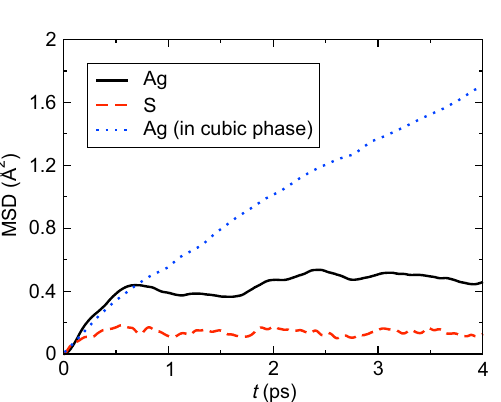
Figure 2. Calculated mean squared displacements (MSDs). MSD of Ag (black solid curve) and S (red dashed curve) ions as a function of time under ambient conditions. The blue dotted curve shows the MSD of Ag ion in cubic superionic conductor phase 23